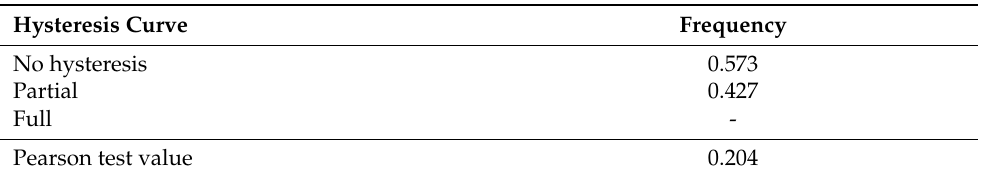
Table 3. Frequency of observations showing hysteresis curves in fruits 2, 3 and 4 in the first period of study. Pearson test was not significant ( p -value > 0.05).